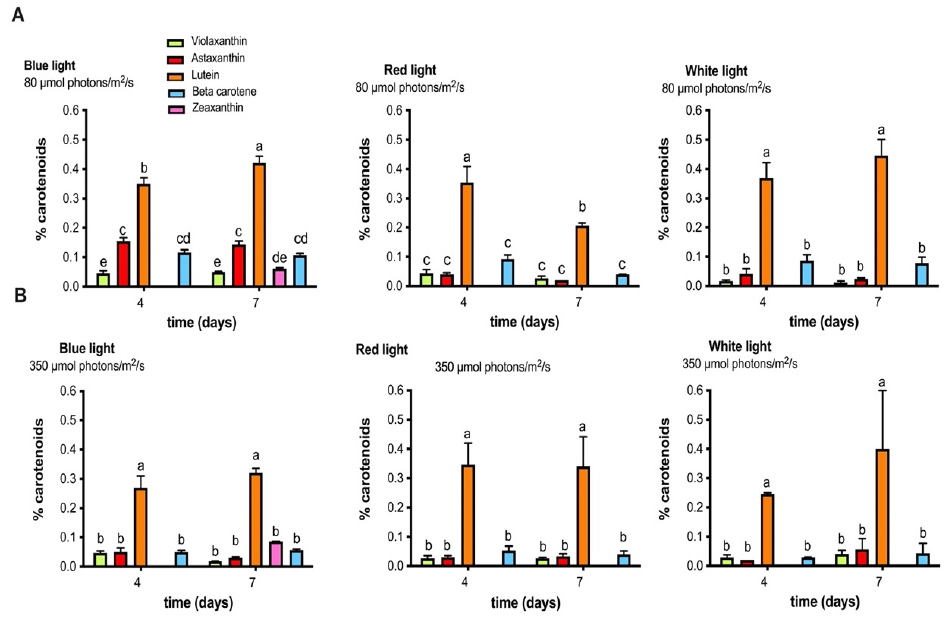
Figure 4. The content of carotenoids (% dry wt), such as lutein, zeaxanthin, violaxanthin, astaxanthin, and beta-carotene, obtained on days 4 and 7 in the microalgae extract of the MCH-35. ( A ) Carotenoid content (%) obtained from blue, red, and white-light culture grown under irradiance of 80 µ mol photons/m 2 /s. ( B ) Carotenoid content (%) obtained from blue, red, and white-light cultures grown at an irradiance of 350 µ mol photons/m 2 /s. Each bar represents the average of four independent measurements. Statistically different values ( p = 0.05, ANOVA two-way, with Tukey posthoc test, n = 3) are indicated by a different letter for each spectral band.